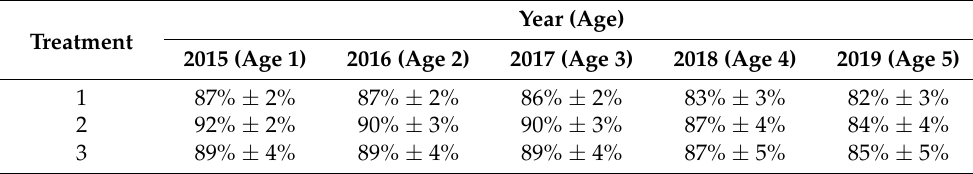
Table 3. Per cent (%) survival rate ( ± SE) of balsam poplar among treatments (1 = 25 selected tolerant clones, 2 = 10 selected control clones, 3 = Stream 1 vegetative lot clones) in the fall of each year.